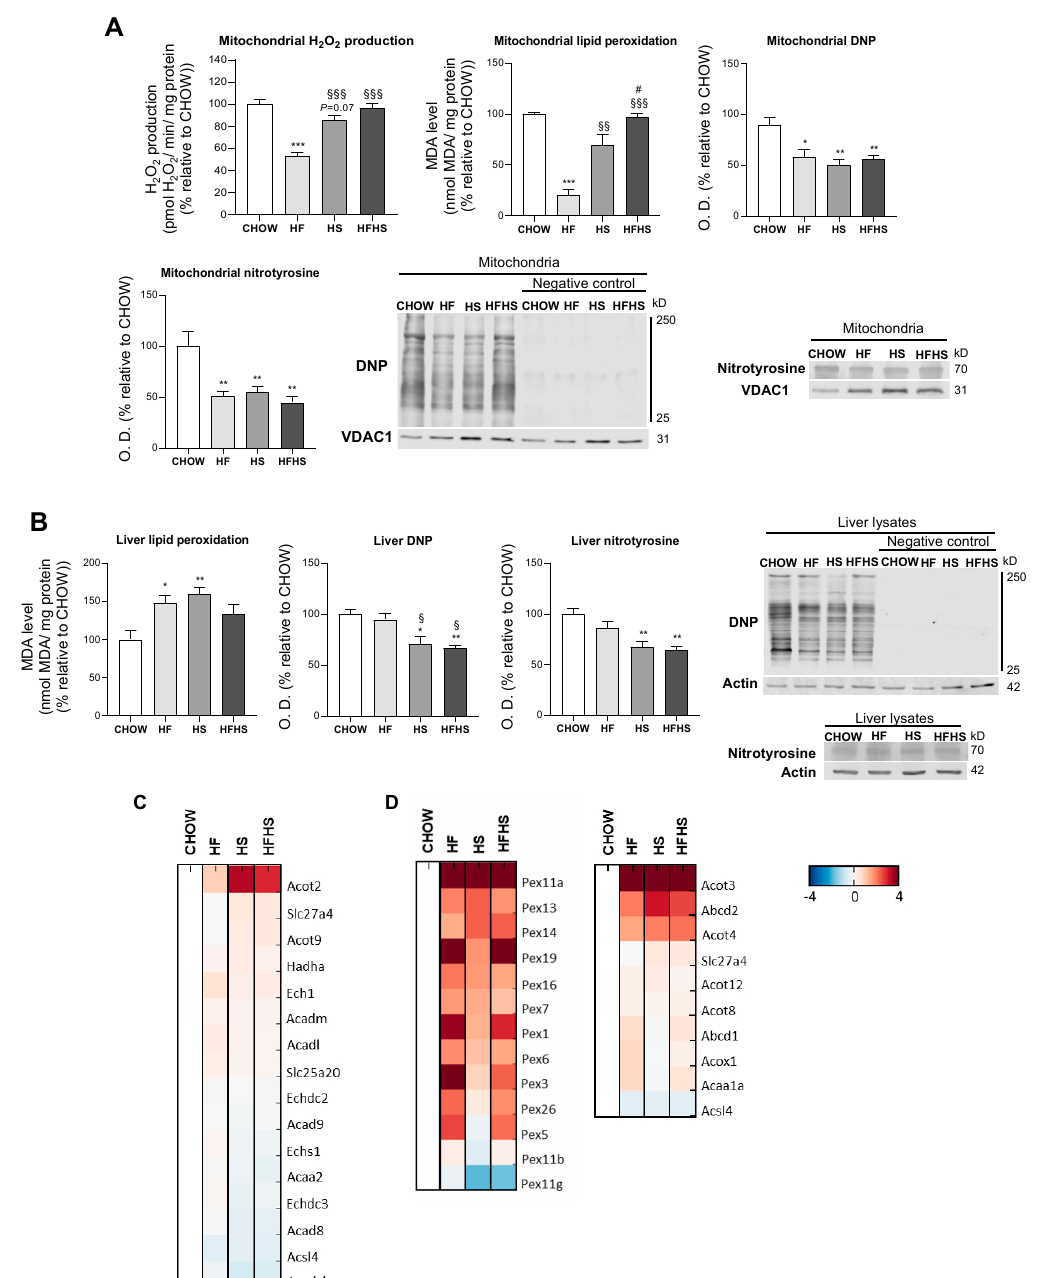
Figure 6. Hepatic oxidative damage with no signs of mitochondrial ROS production in diet-induced nonalcoholic fatty liver (NAFL). ( A ) Rate of mitochondrial H 2 O 2 production, levels of mitochondrial lipid peroxidation and optical density (arbitrary units) of mitochondrial protein oxidative damage (DNP and nitrotyrosine), with representative Western blot images. VDAC1 was used as a loading control ( N = 4). ( B ) Levels of lipid peroxidation and optical density (arbitrary units) of protein oxidative damage (DNP and nitrotyrosine) in hepatic tissue lysate, with representative Western blot images. Actin was used as a loading control ( N = 4). ( C ) Proteomic analysis of protein